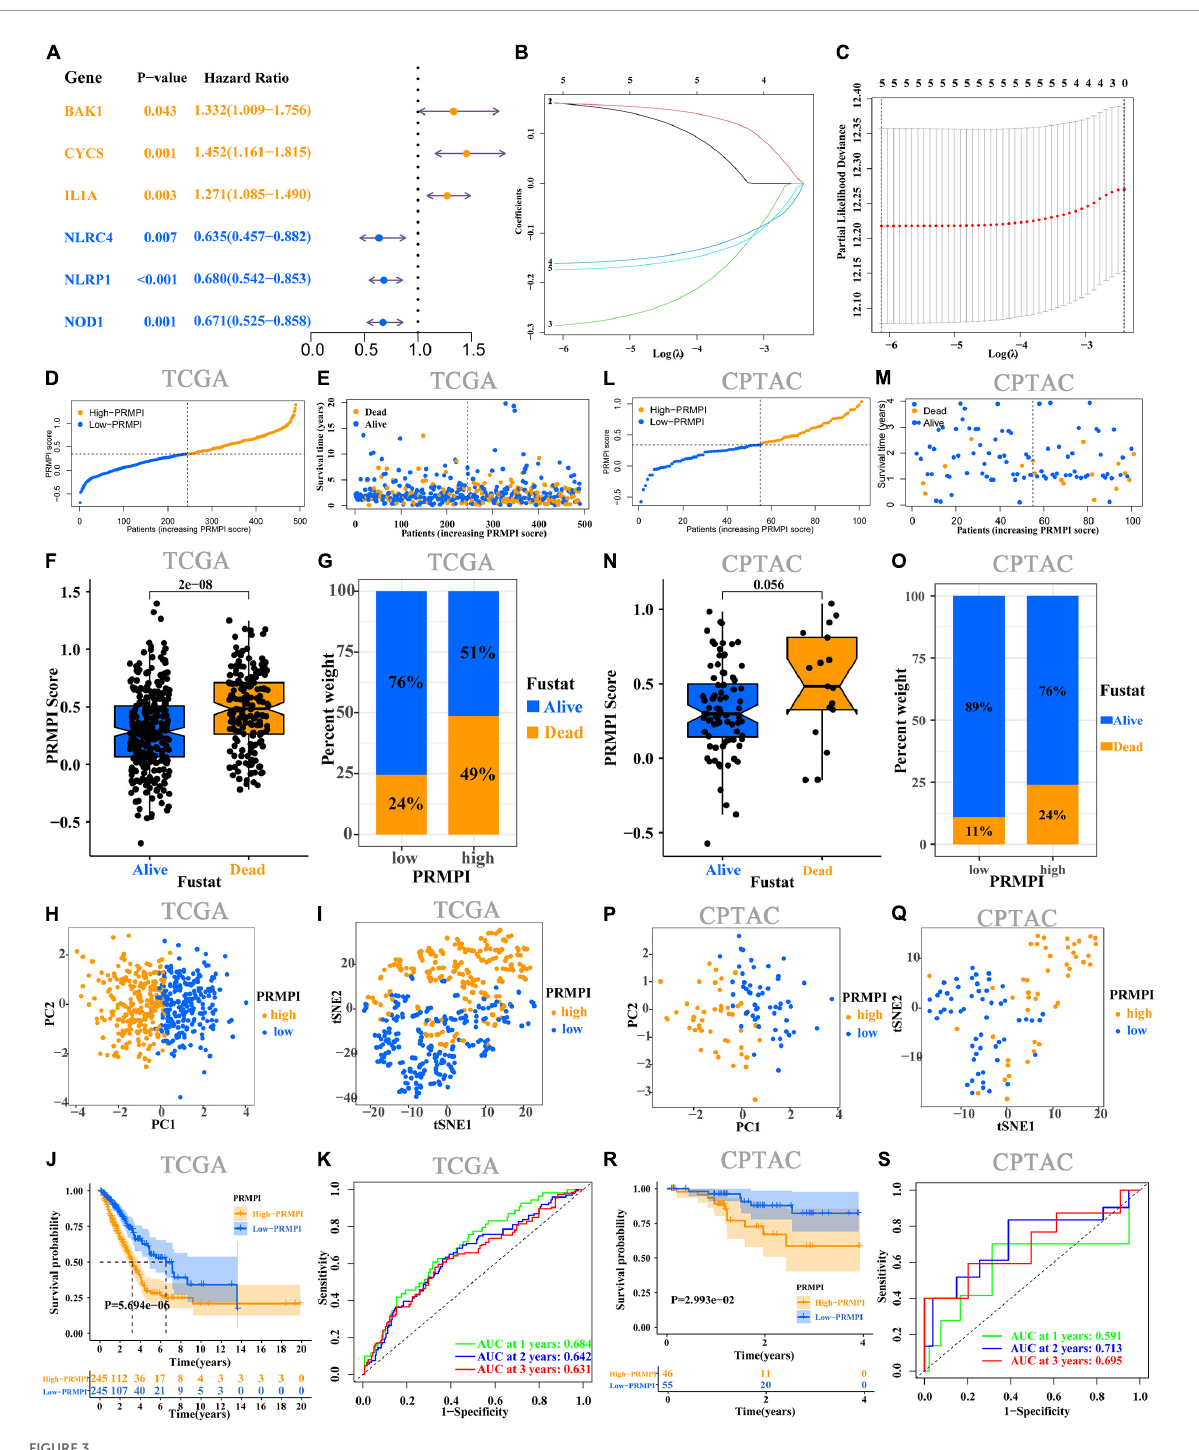
FIGURE3 Construction and prognostic analysis of PRMPI. (A) Univariate Cox regression analysis for 36 DEPRMs. (B) LASSO Cox regression coefficients of five DEPRMs with prognostic significance. (C) Cross-validation of tuning parameter selection in the LASSO Cox regression. (D) Distribution of patients with LUAD based on the PRMPI score. (E) Follow-up time and survival status for each patient with LUAD. (F) Comparation of PRMPI score between alive and dead LUAD patients. (G) Proportion of alive and dead patients in two PRMPI subgroups. PCA plot (H) and t-SNE analysis (I) . (J) Kaplan–Meier survival analysis of the low-PRMPI and high-PRMPI subgroups. (K) ROC analysis of PRMPI scores on OS at 1-, 2-, and 3-year follow-ups. (L–S) Relationship between the PRMPI and survival was validated by RNA-seq and clinical data from the CPTAC cohort. PRMPI, pyroptosis-related mRNA prognostic index; DEPRMs, differentially expressed pyroptosis-related mRNAs; PRMs, pyroptosis-related mRNAs; LUAD, lung adenocarcinoma; OS, overall survival; ROC, receiver operating